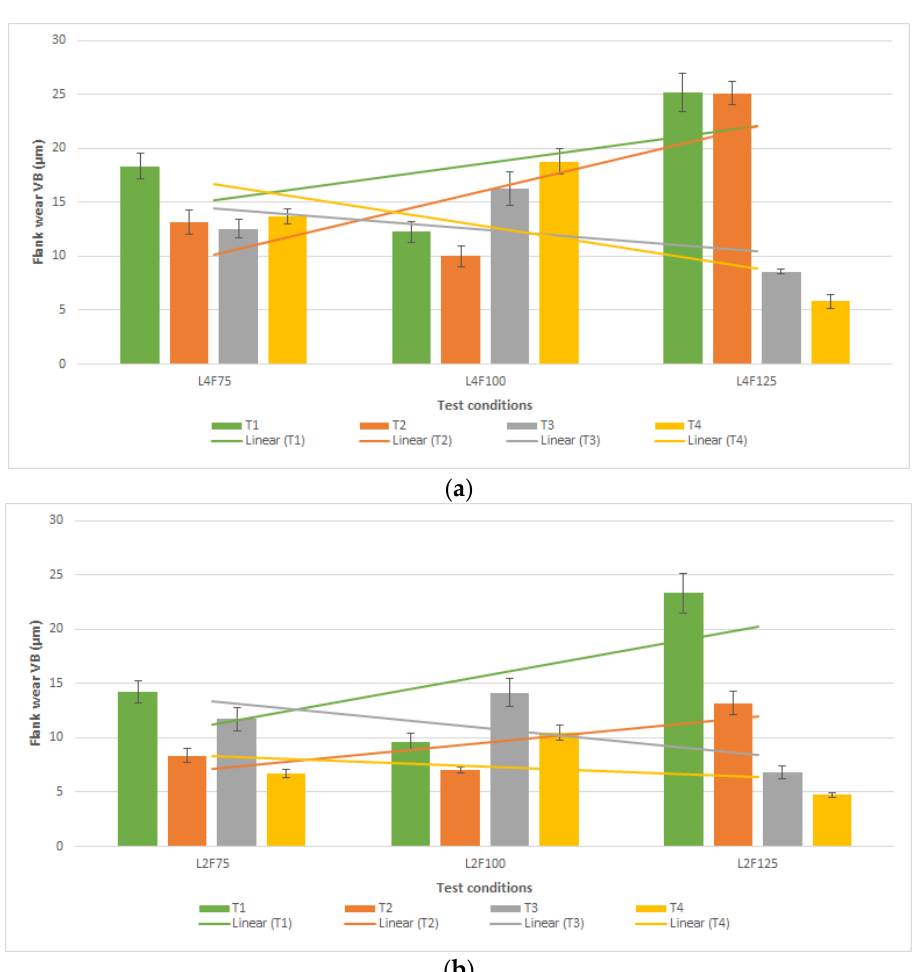
Figure 23. Average values of VB, measured on the clearance faces of the T1, T2, T3 and T4 tools, for the test conditions conducted at 2-m cutting length ( a ); and 4-m cutting length ( b ).